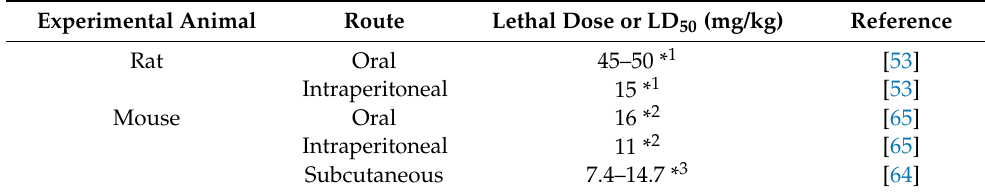
Table 3. Lethal dose or LD 50 of tetramine to experimental animals. Experimental Animal